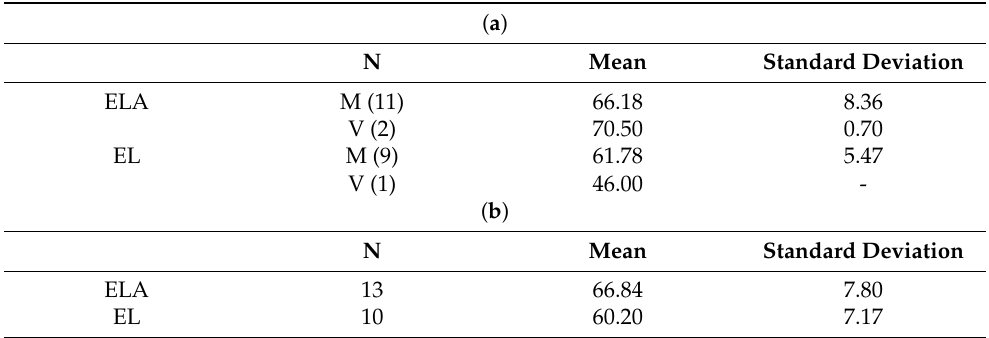
Table 3. ( a ) Mean age of Korsakoff’s syndrome patients in the errorless learning application (ELA) and errorless learning (EL) groups. ( b ) Mean total age of Korsakoff’s syndrome patients in the errorless learning application (ELA) and errorless learning (EL) groups.